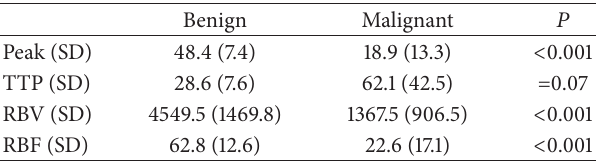
Table 3: Differences in microvascularization between benign and malignant lesions.